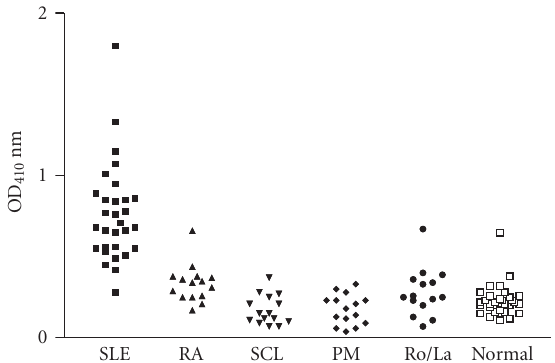
Figure 5: Reaction of SLE sera and control sera with the purified bacterial antigen. The sera were 1/100 in PBS and added into purified bacterial antigen-coated ELISA plates and the reaction of sera antibodies with the purified bacterial antigen were detected by goat antihuman IgG Fc fragment specific alkaline phosphatase con- jugate. The 30 SLE sera and the control sera include 15 rheumatoid arthritis, 15 polymyositis dematomyositis, 15 sclerodema, 15 Ro/La positive sera, and 30 normal sera. The mean reading of 30 SLE sera bound with purified bacterial antigen was statistically di ff erent from that of control sera ( P < . 0001 by unpaired t -test).